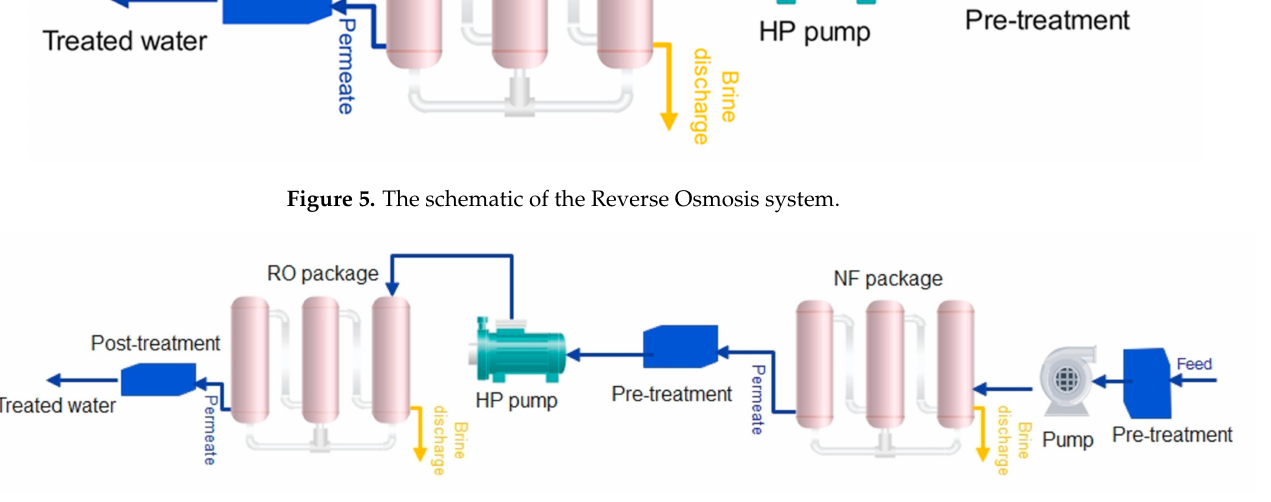
Figure 6. The schematic of case 5 (hybrid